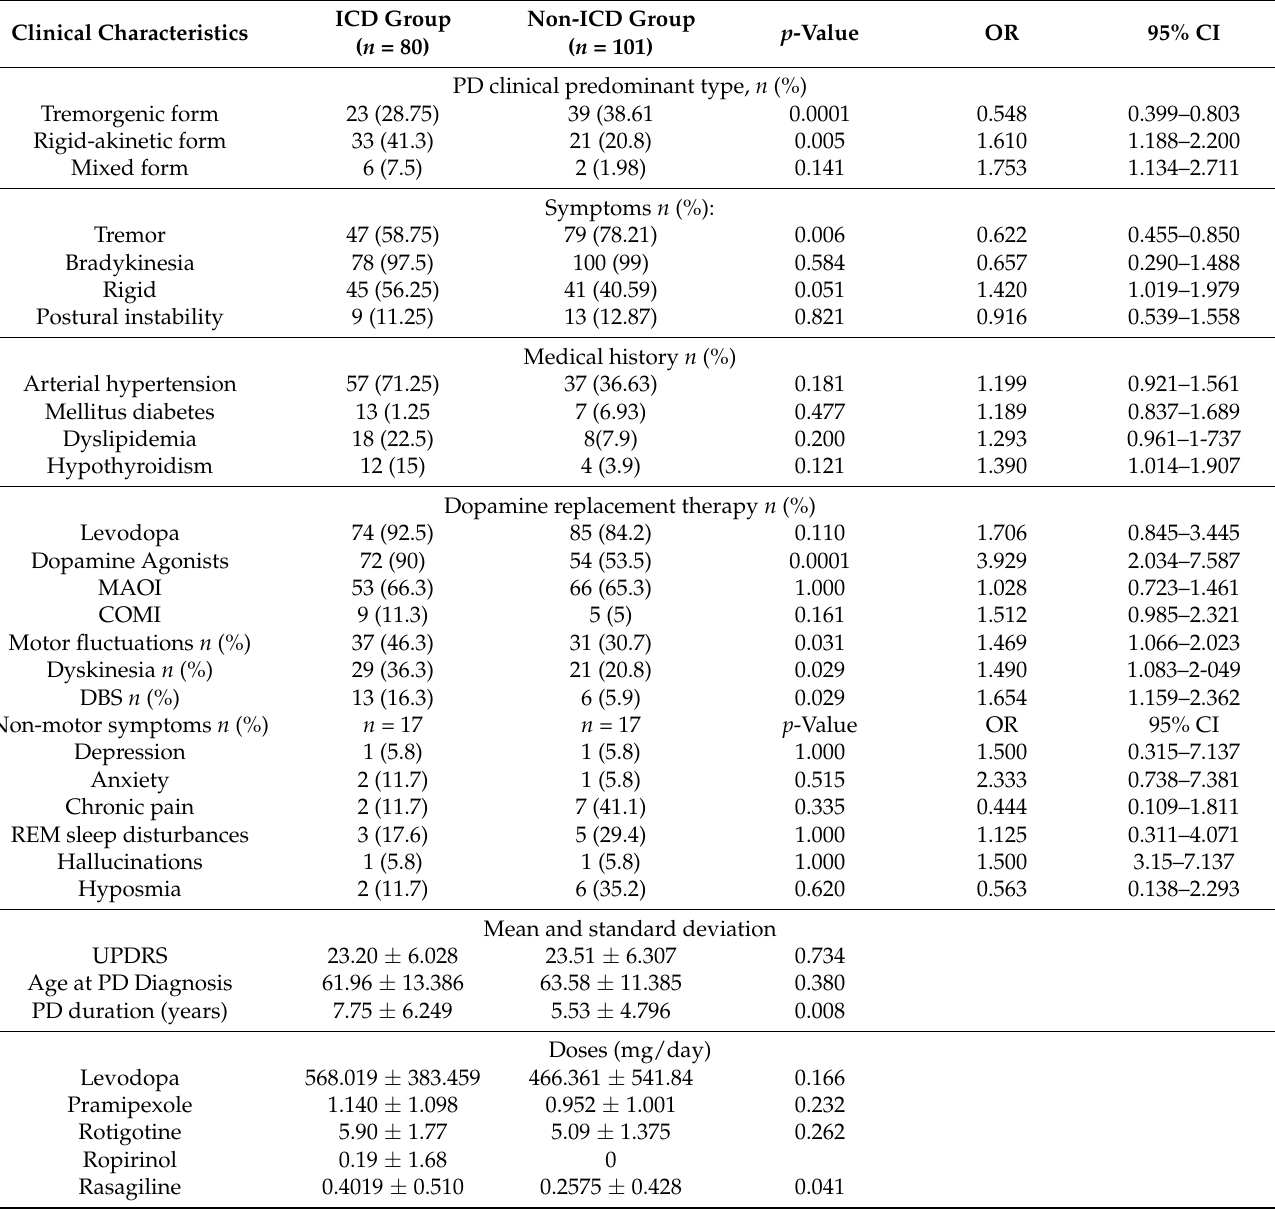
Table 2. Clinical characteristic of both groups and their association with the outcome Impulse Control Disorders